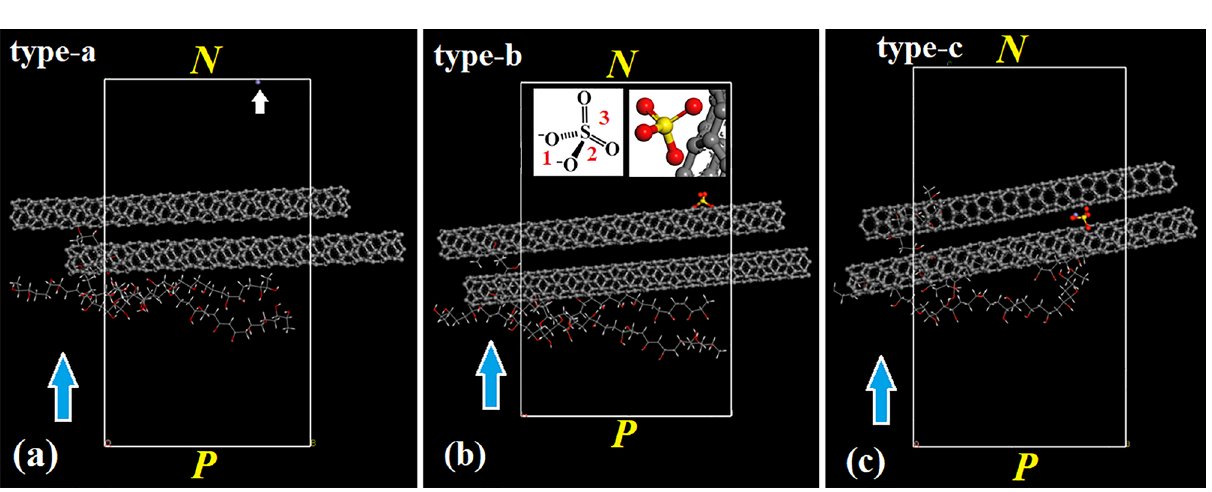
Figure 7. Snapshots extracted from geometric optimization of type - a at E = 600 V/cm and t = 1 s ( a ), type - b at E = 600 V/cm and t = 1 s ( b ) and type - c at E = 600 V/cm and t = 1 s ( c